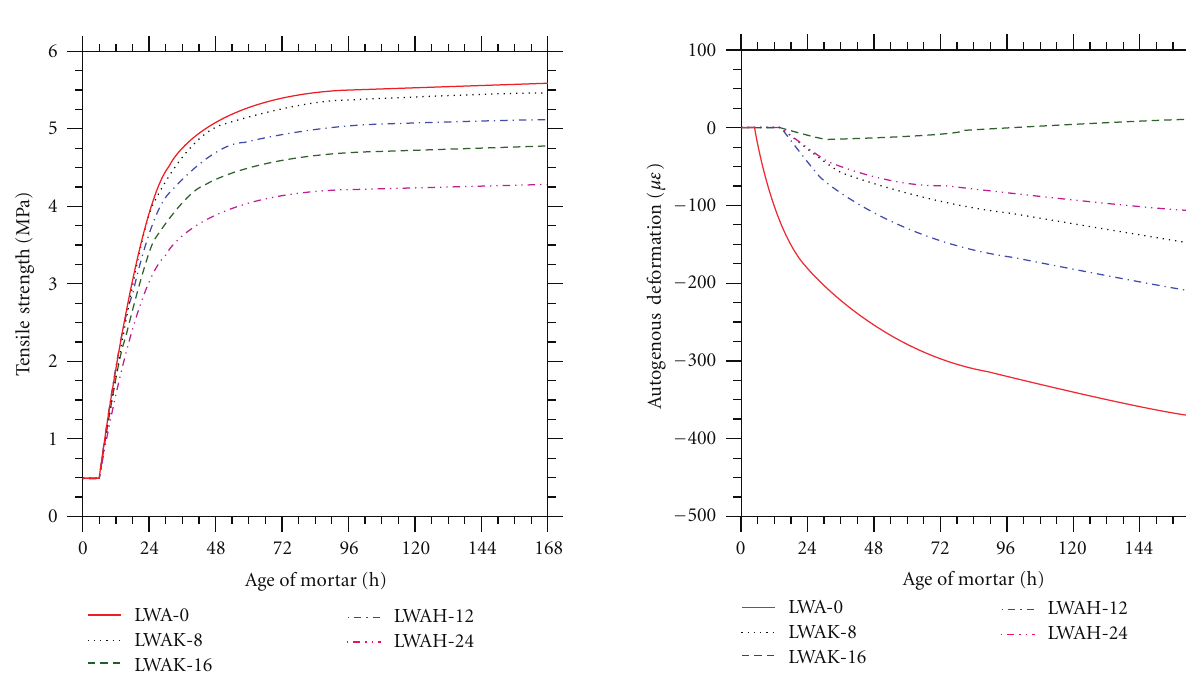
Figure 3: Tensile strength development of mortar mixtures (fitted) [23].